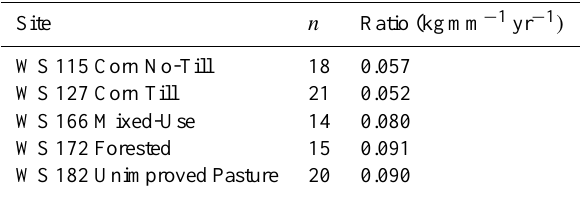
Table 3. Mean DSi yield (kgkm − 2 yr − 1 ) divided by specific dis- charge (mmkm − 2 ) for NAEW watersheds to calculate average an- nual DSi yield per mm flow, n = number of